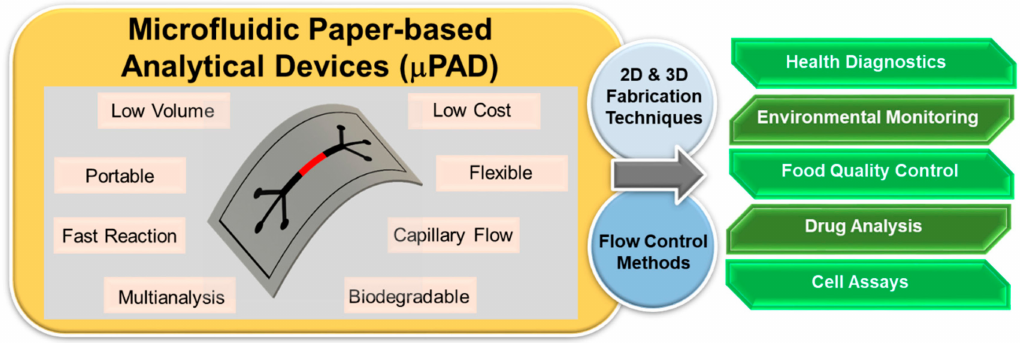
Figure 1. Schematic diagram of the advantages and potential applications of 2D & 3D microfluidic paper-based analytical